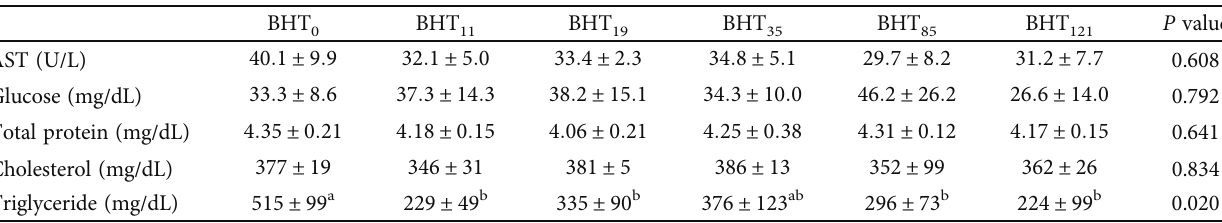
Table 4: Hematological parameters of olive fl ounder ( Paralichthys olivaceus ) fed various levels of BHT-supplemented diets for 120 days 1